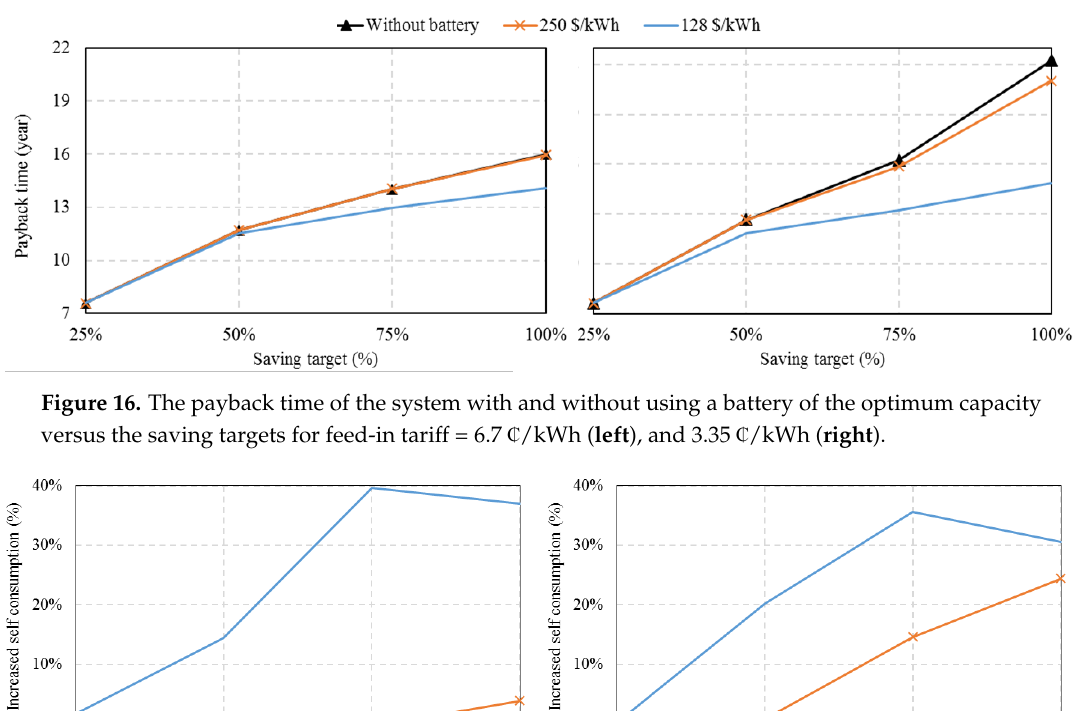
Table 2. Assumptions made in the present work.